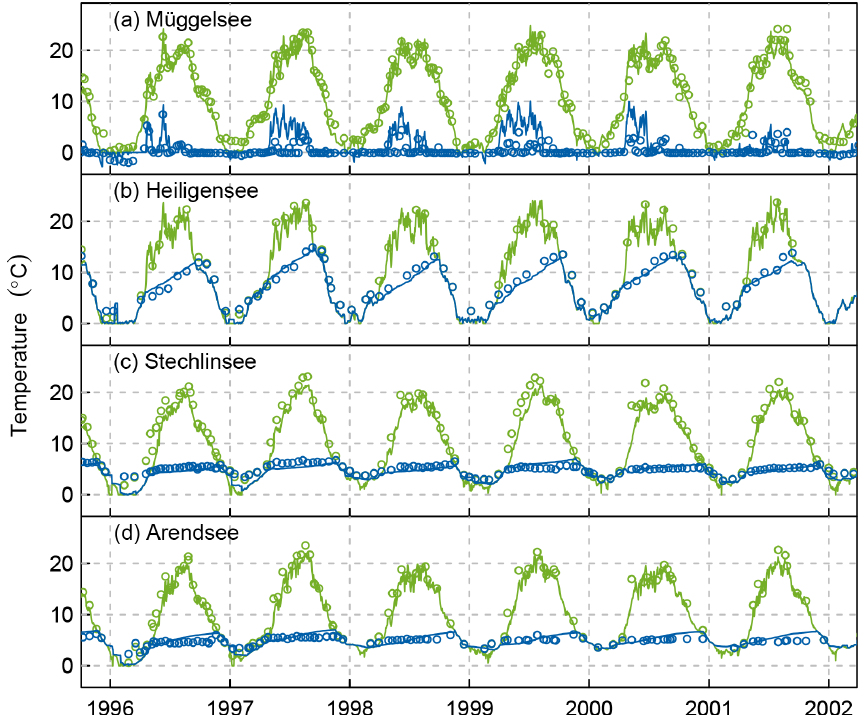
Figure 5. Comparison of modelled (lines) and observed temperatures (points) in Müggelsee (a) , Heiligensee (b) , Stechlinsee (c) , and Arend- see (d) . Green lines and symbols show surface temperatures, blue lines and symbols show bottom temperatures (b–d) or surface–bottom temperature differences (a)